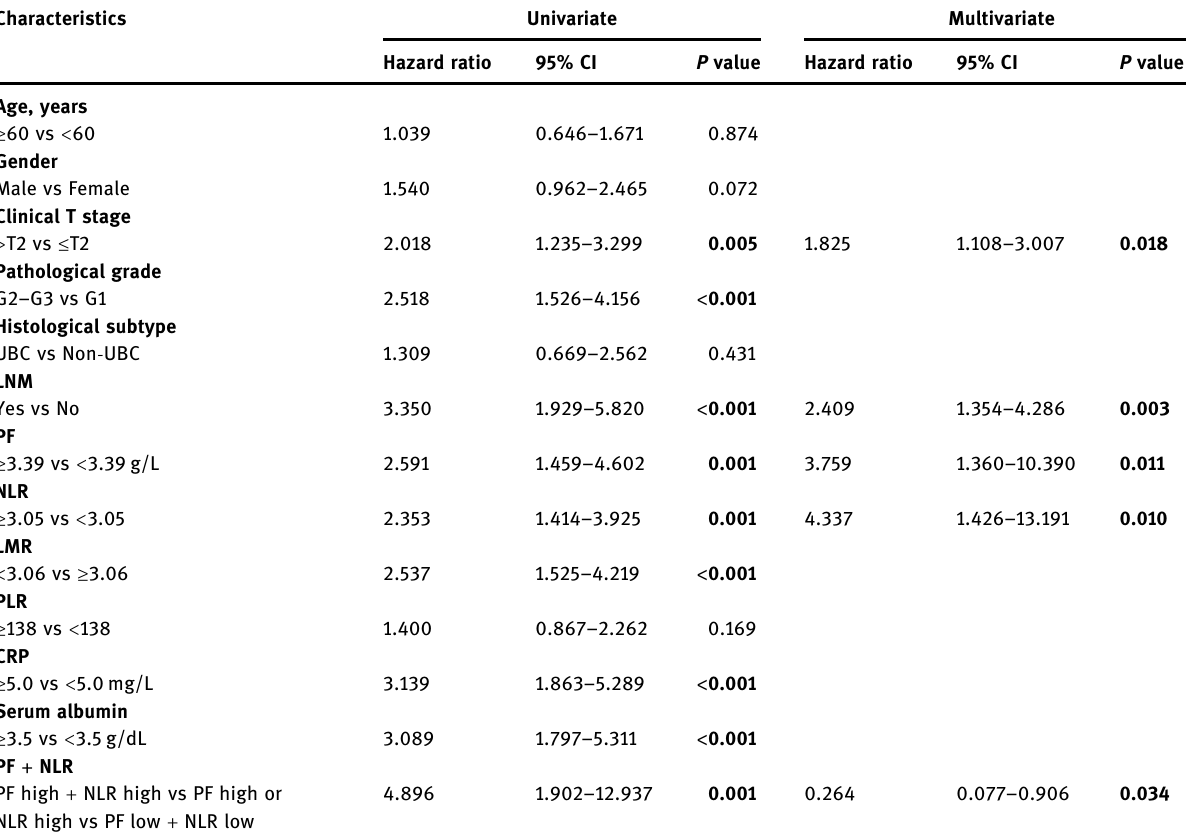
Table 2: Univariate and multivariate analyses of characteristics associated with OS in 136 BC undergoing RC patients